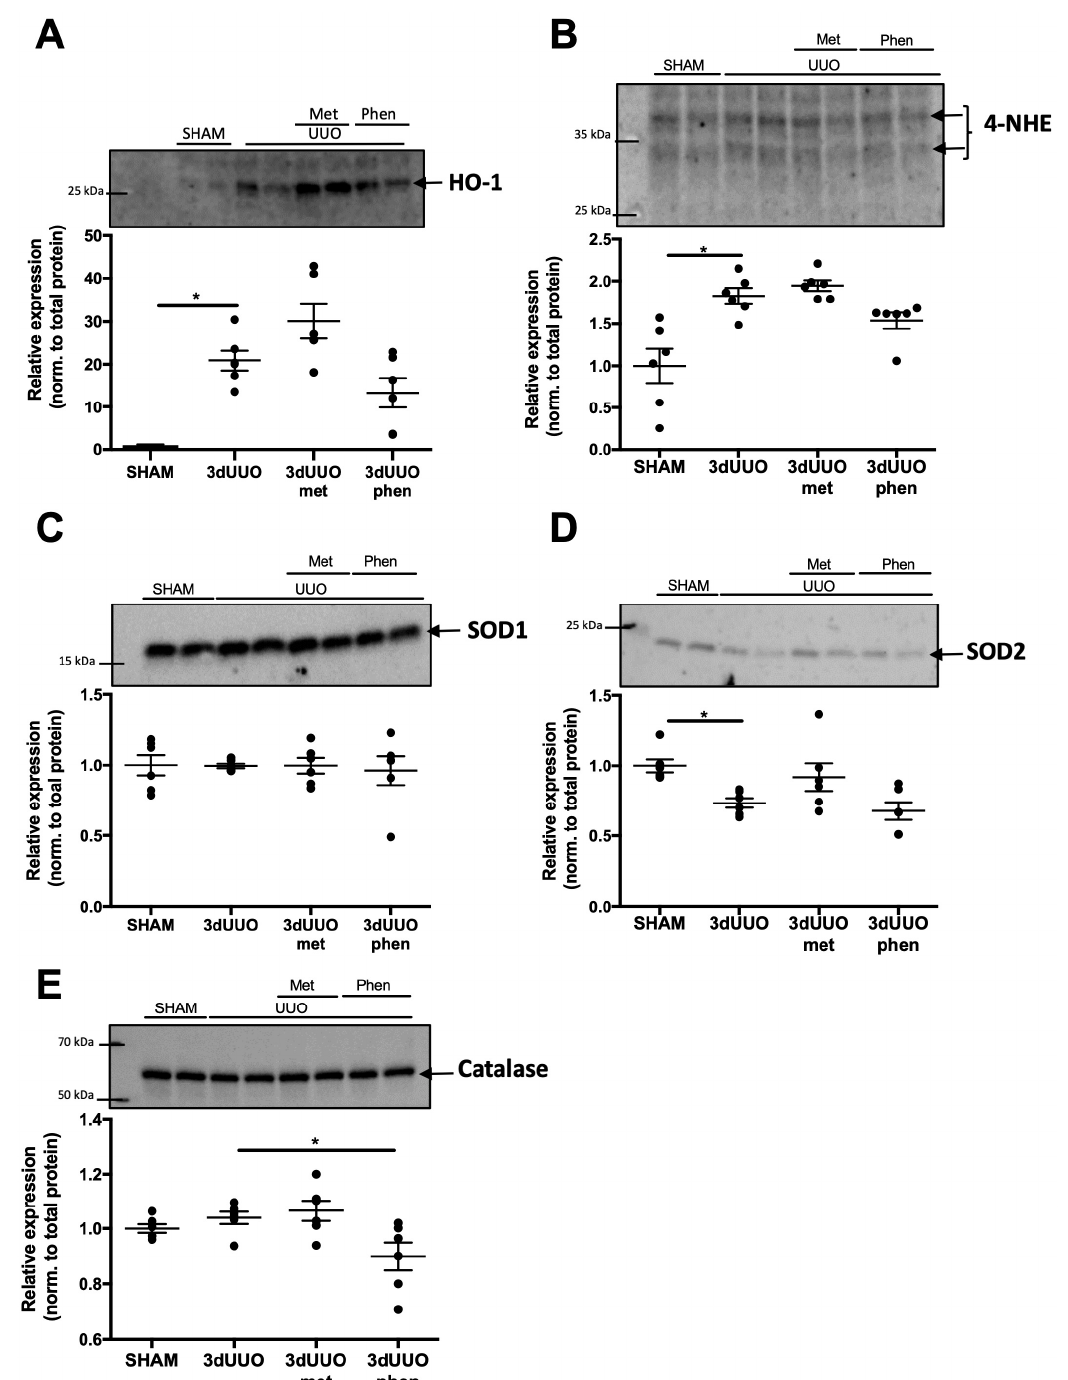
Figure 4. Regulation of oxidative stress markers and antioxidants following UUO and biguanide treatment. ( A–E ) Protein expression of the oxidative stress markers Hemeoxygenase-1 (HO-1), 4-Hydroxynonenal (4-HNE), Superoxide dismutase 1 and 2 (SOD1, 2), and Catalase in response to UUO and biguanide treatment normalized to total protein. n = 6 for each group. Each bar represents the mean ± SEM. * p < 0.05.